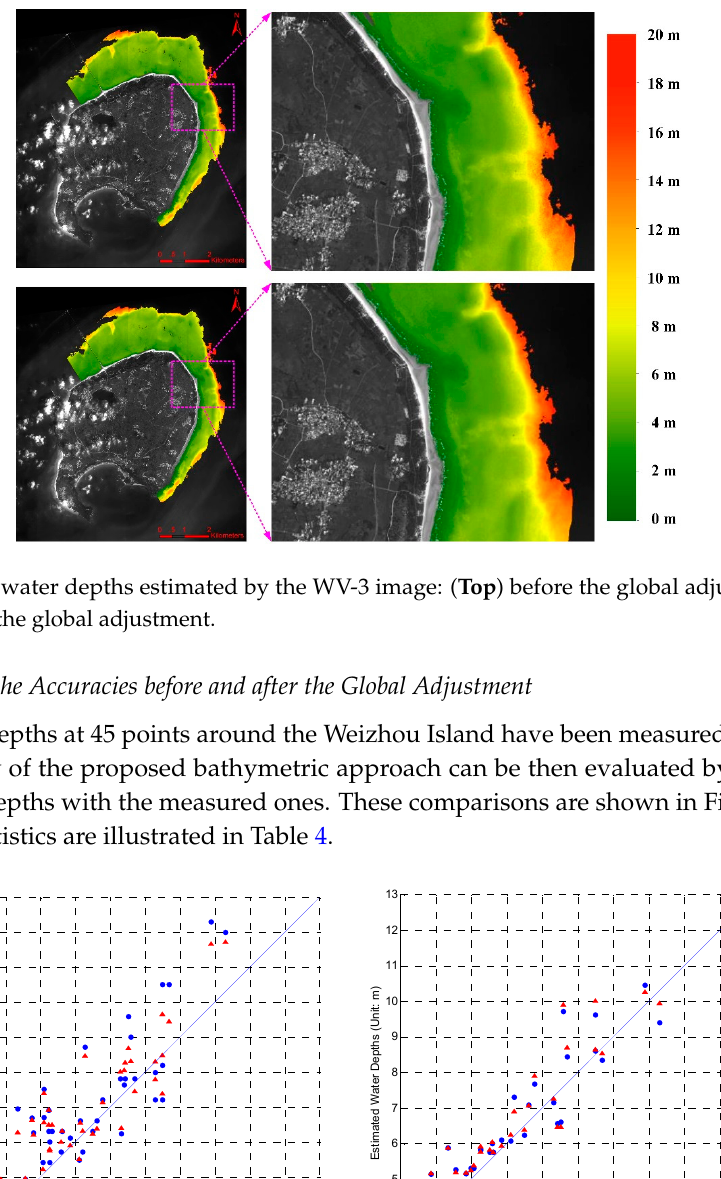
Figure 11. The comparisons between the estimated and measured water depths: ( a ) ZY-3; and ( b ) WV-3.